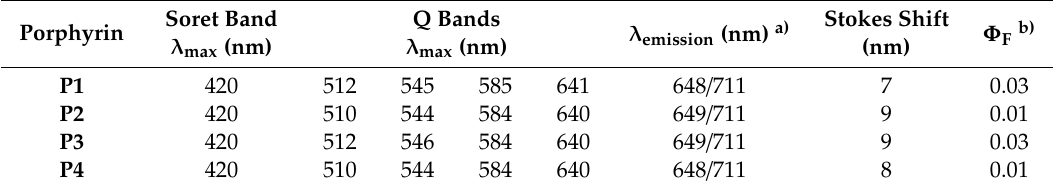
Table 1. Selected photophysical properties of porphyrins P1–P4 in DMF. Porphyrin